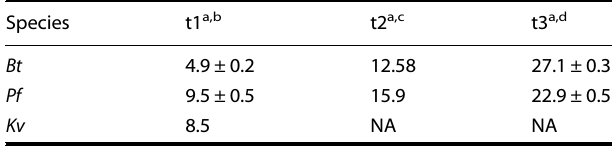
Table 1. Characteristic times of individual species expansion in the 4S bio fi lm in the whole channel.